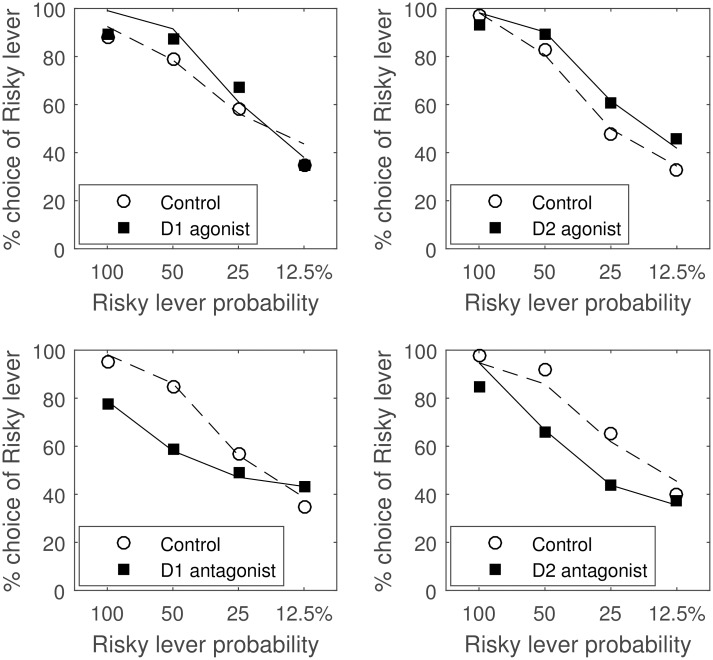
Effect of dopaminergic receptor manipulations on risky choices.In each panel the percentage of risky choices is plotted against the probability of obtaining the large reward by choosing the risky lever. Open circles show the data from animals in the control state, while filled squares show the data obtained after treatment with a drug. Each panel corresponds to a different drug indicated in the key. The data in each panel were read from one figure in [32] and averaged over different drug concentrations. In particular, the data in the four panels come from Figs 3c, 4c, 3a and 4a in [32]. Solid and dashed curves show the fractions of risky choices made by the model, simulated for parameters corresponding to control and drug conditions. During each simulation the model made 10,000 choices in each of four probability conditions (thus the standard error of mean fraction of risky choices made by the model was < 1%). This large number of simulated trials allowed the model to produce stable behavior, which was necessary for the search for parameters resulting in a match with animal behavior.